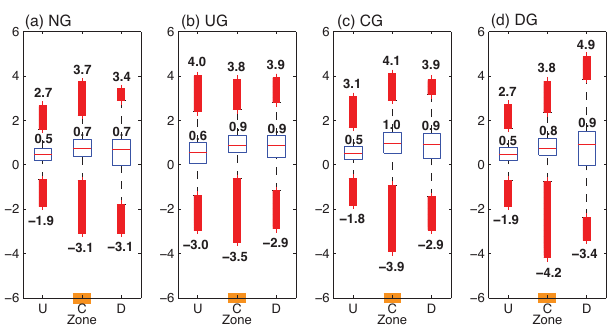
Figure 8. Box and whisker plots of instantaneous u component of the wind (ms − 1 ) within the canopy for case (a) NG, (b) UG, (c) CG, and (d) DG. From left to right in each panel, plots correspond to grid points in the upstream, center, and downstream zones (see Fig. 1 and canopy outlines in Fig. 2b–d for illustration of zones); fire location indicated by orange rectangle. For each box and whisker plot, the top and bottom of the box denotes the 75% ( q 3 ) and 25% ( q 1 ) per- centiles, the horizontal red line denotes the median, the whiskers extend away from the box to the highest and lowest points not con- sidered outliers, and the red bars extend outward from the whiskers to the maximum and minimum values. Note that the median, maxi- mum, and minimum values are labeled for each plot.